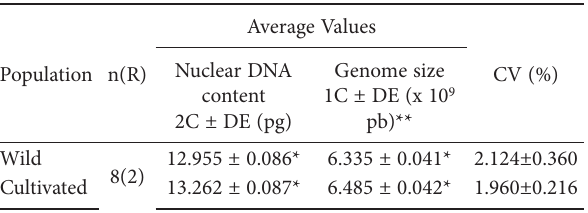
Table 2. Flow cytometry was used to quantify the nuclear DNA content and genome size of wild and cultivated populations of Physalis peruviana L. using Pisum sativum cv . Ctirad as the internal reference